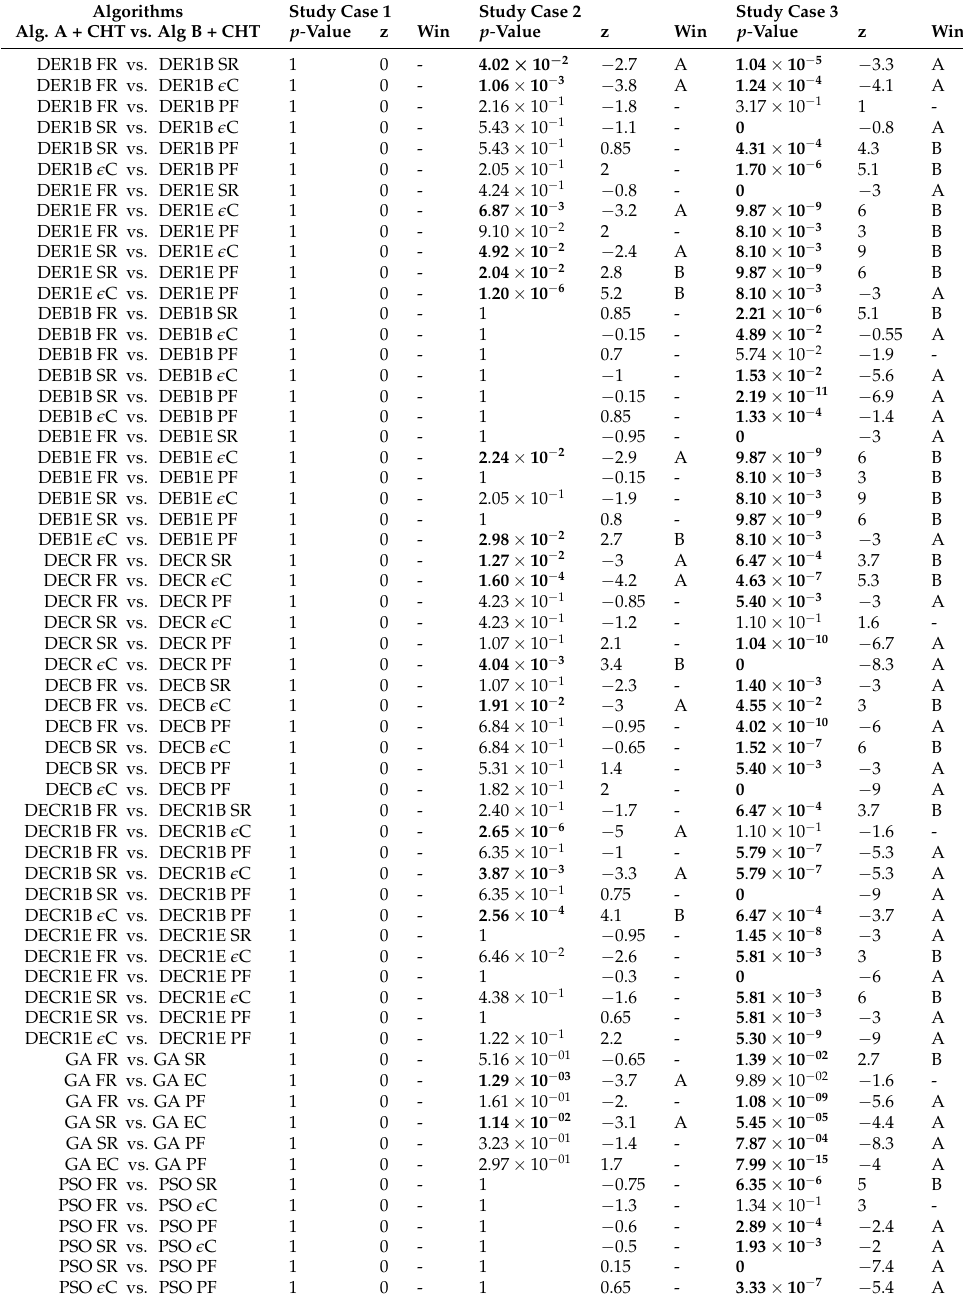
Table A20. Multiple comparison Friedman test with the post-hoc correction method for the overall performance of the four CHTs included into the ten metaheuristic algorithms for the EVALS metric. “-” indicates that there is no winning